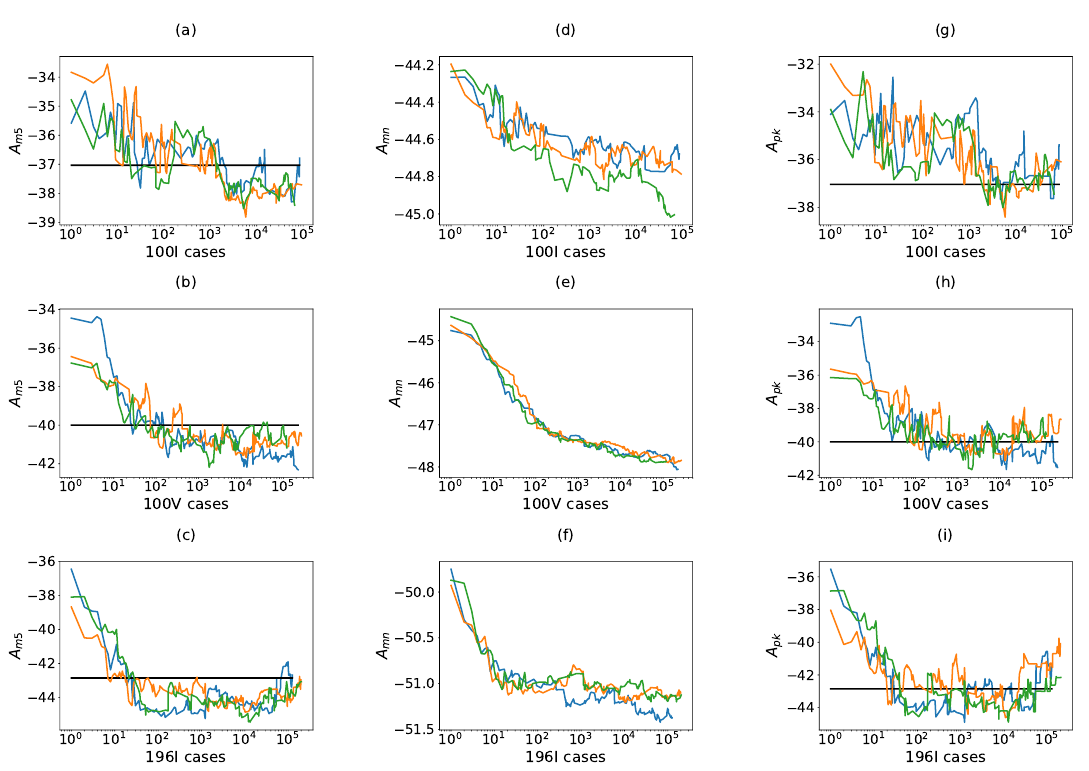
Figure 9. Coarray-based fitness function. Each row analyses the evolution of the dynamic range in one specific configuration. For 100I: ( a ) A m 5 , ( d ) A mn , ( g ) A pk . For 100V: ( b ) A m 5 , ( e ) A mn , ( h ) A pk . For 196I: ( c ) A m 5 , ( f ) A mn , ( i ) A pk . For each configuration three different evolution processes are presented (colors blue, orange and green). In the figures where A pk or A m 5 are presented, the threshold line TH A has been m 5